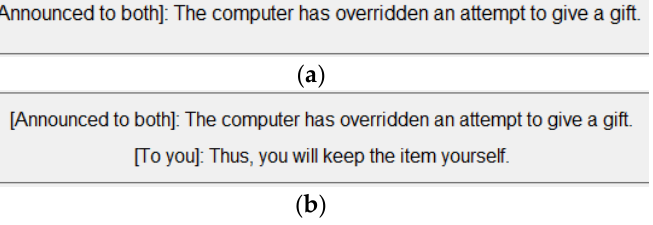
Figure 3. Gift treatment screenshots. ( a ) Gift‐giver’s screen with item; ( b ) Dictator’s screen with item; ( c ) Message to dictator when no gift was given.